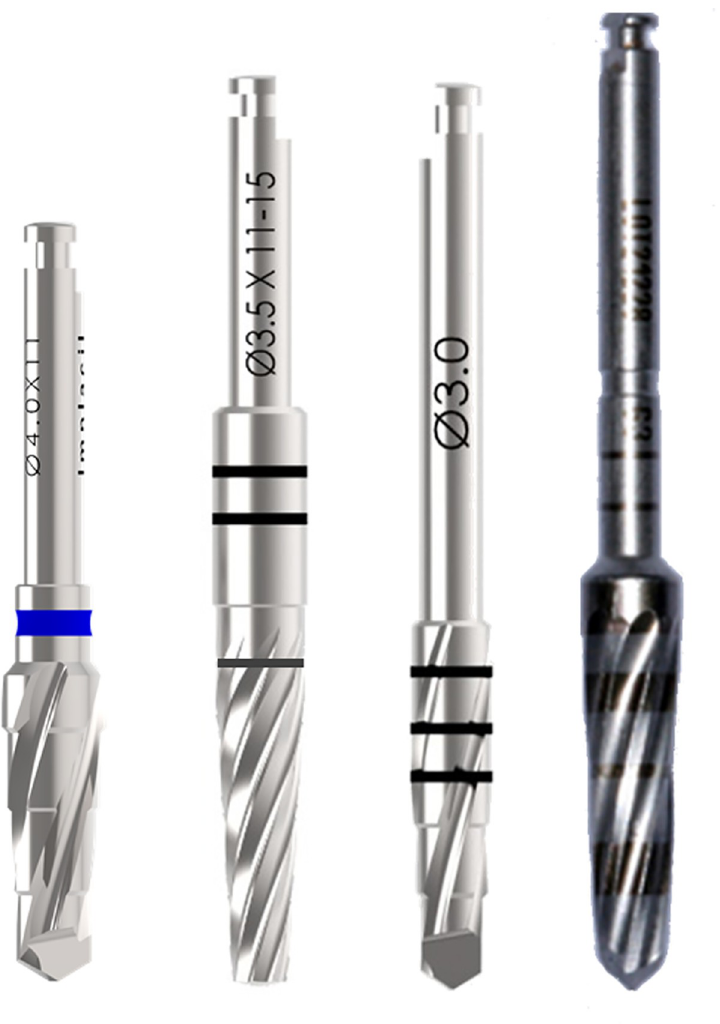
Fig 1. Representative image of the last instrument used in the osteotomy for each group: G1, G2, G3, and